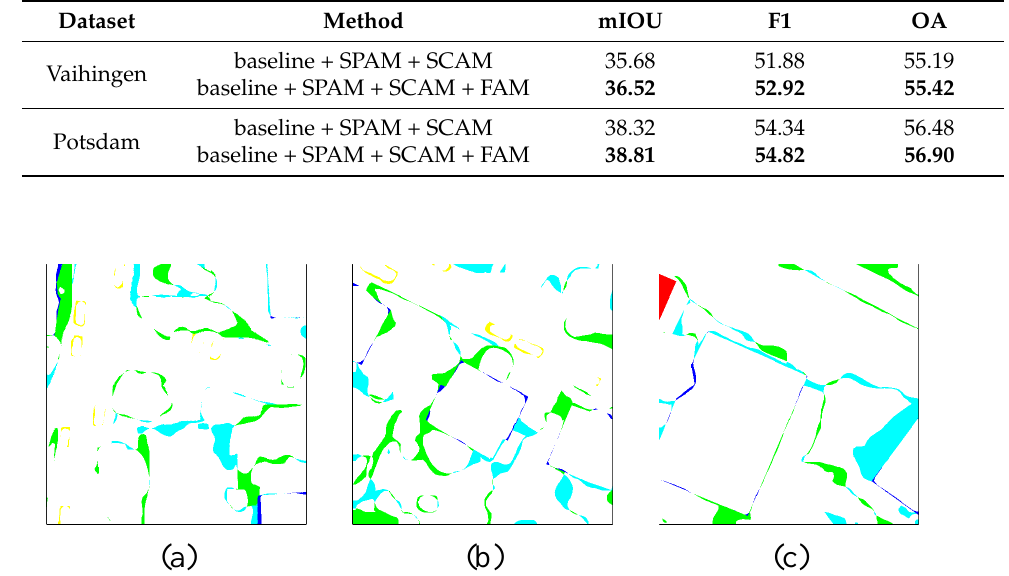
Figure 10. Visualization results of the difference between predictions and labels. ( a – c ) from the test set of the Vaihingen dataset. Note that most of the regions with inaccurate segmentation are boundary